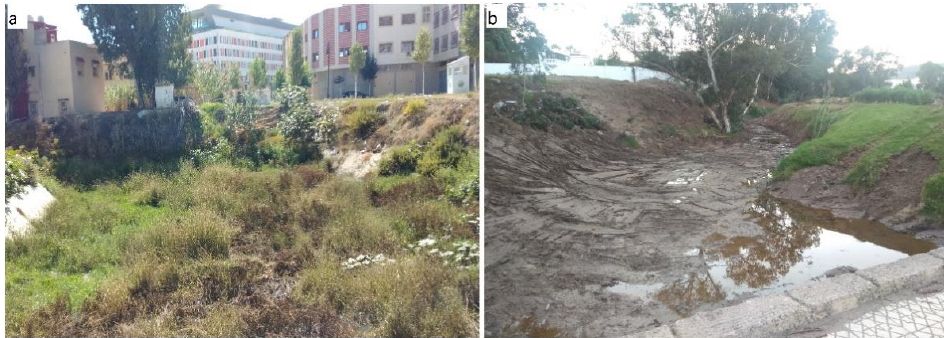
Figure 7. ( a ) Drainage channel not maintained or cleaned, ( b ) and drainage channel maintained and cleaned before the start of the rainy season (September 2021) in the city of